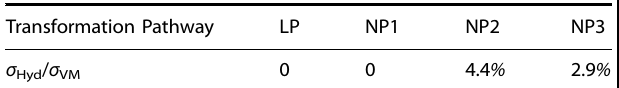
Table 2. Ratio of the far- fi eld hydrostatic stress σ Hyd to von Mises stress σ VM associated with the critical nucleus of different transformation pathways.